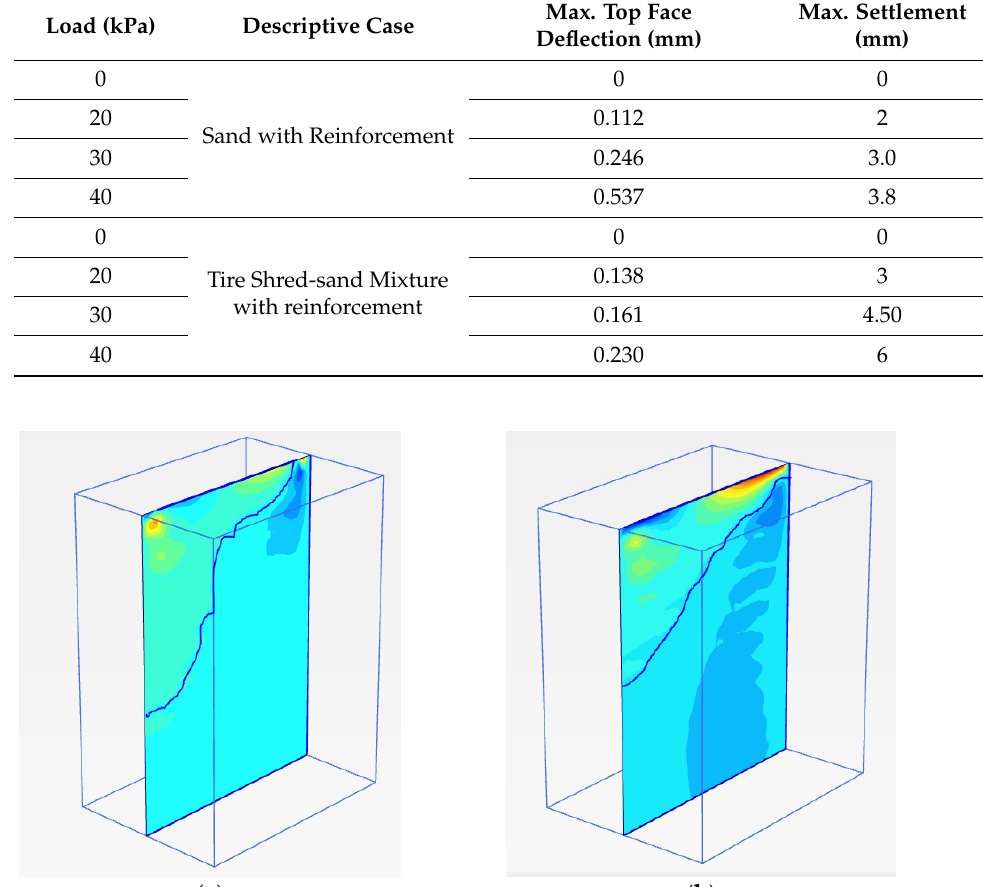
00.10.20.30.40.50.6 0